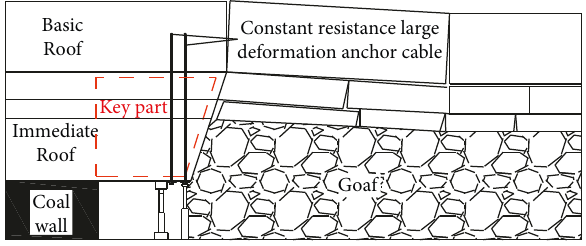
Figure 1: Principle of roof cutting and pressure releasing gob-side entry